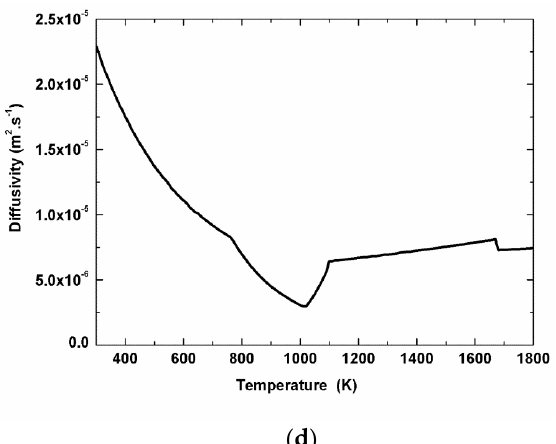
Figure 4. ( a ) Effect of the arc length on the evolution of the weld pool width; ( b ) Effect of the arc length on the evolution of the weld pool shapes; ( c ) Effect of the arc length on the depth-to-width ratio; ( d ) Mechanism of the weld pool expansion: thermal diffusivity.